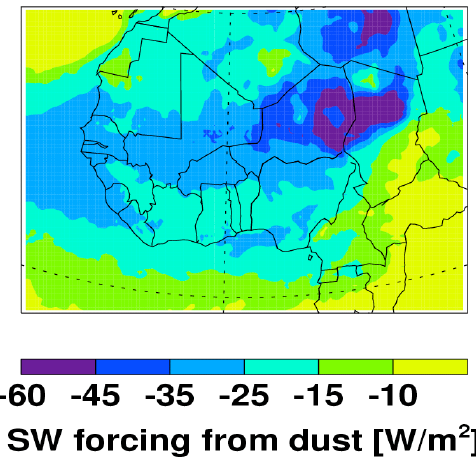
Figure 12 Clear-sky surface SW dust radiative forcing at 12 UTC over North Africa for 7 Fig. 12. Clear-sky surface SW dust radiative forcing at 12:00UTC over North Africa for the simulation period estimated from the the simulation period estimated from the WRF-Chem simulations in the Sect1-G case. 8 WRF-Chem simulations in the Sect1-G case. The SW dust radia- tive forcing is estimated by subtracting the result from the simula- The SW dust radiative forcing is estimated by subtracting the result from the simulation 9 tion without dust emissions from that from the simulation with dust without dust emissions from that from the simulation with dust emissions. 10